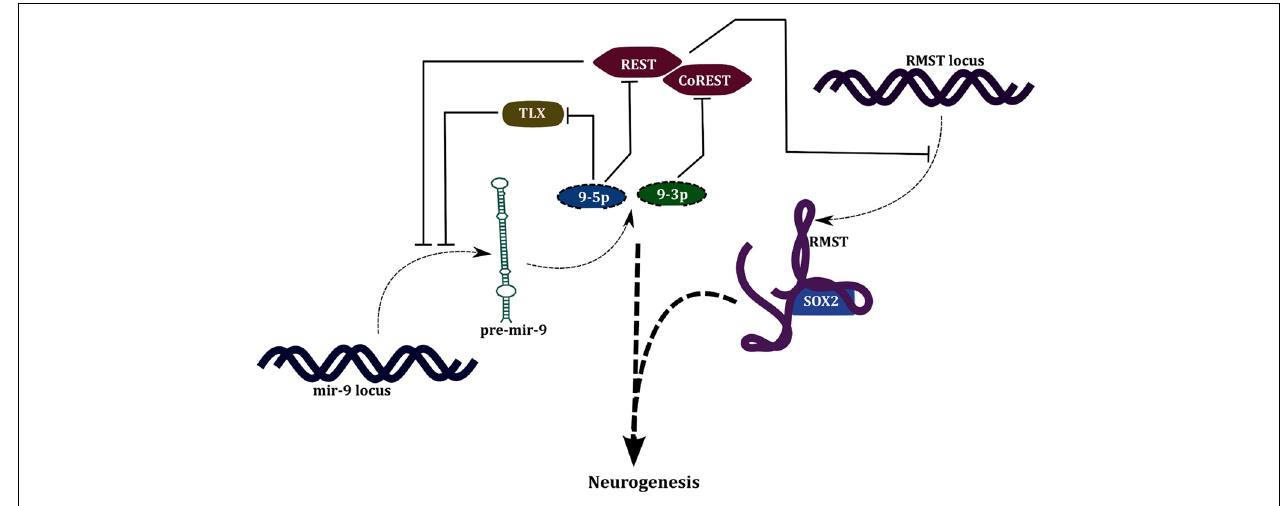
FIGURE 4 | Regulation of neurogenesis by miR-9 and lncRNA-